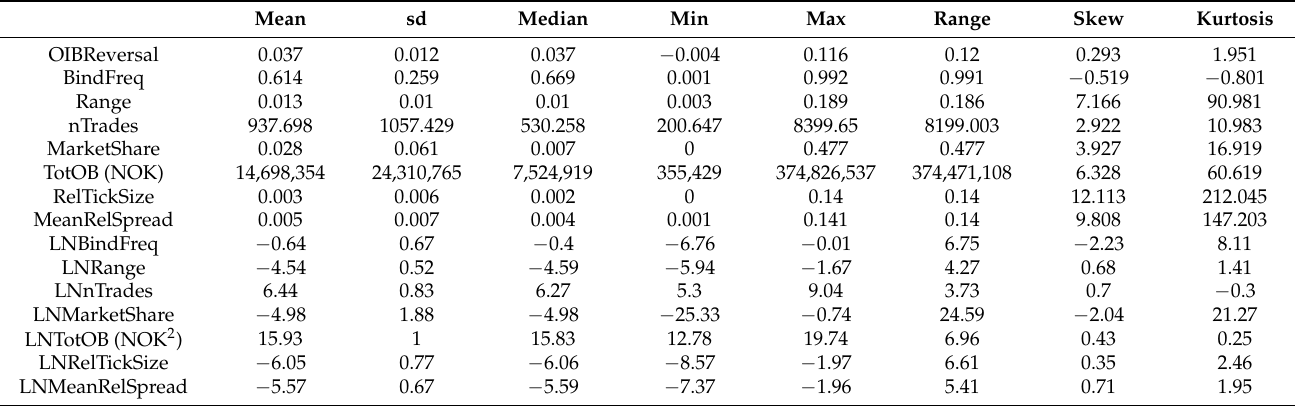
Table 2. Data summary.